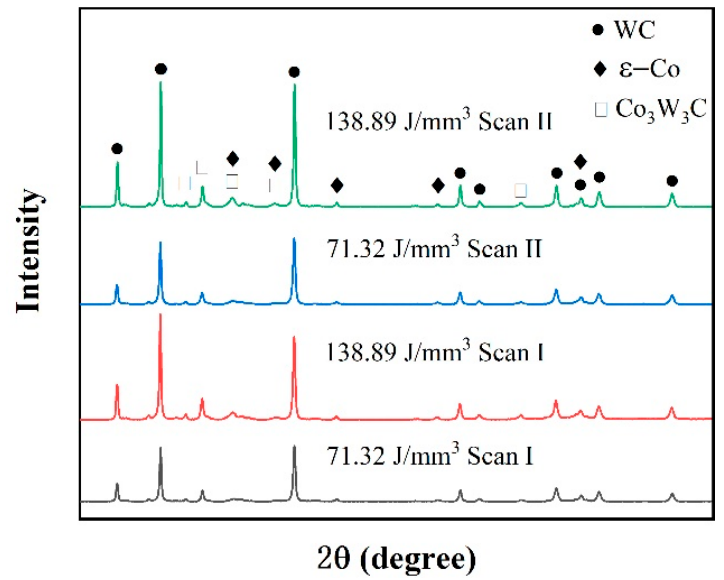
Figure 13. XRD spectrum of specimens formed under different process parameters and scanning strategies.